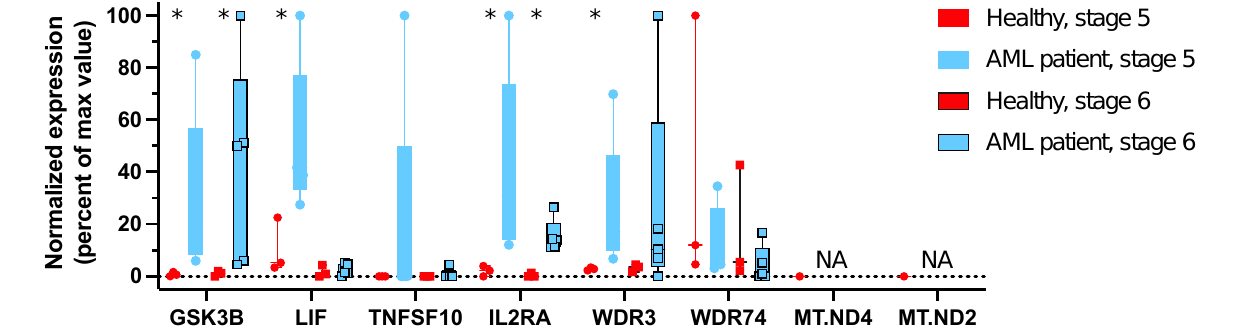
Figure 5. The downregulated genes identified in GSK3B -KO NK cells were mostly upregulated in GSK3β -overexpressing NK cells from patients with AML. RNA-seq analysis was performed on NK cells at different stages of maturation isolated by sorting from healthy donors and patients with AML. * p ≤ 0.05. (Healthy d onors, n = 3; AML patient, n = 5).